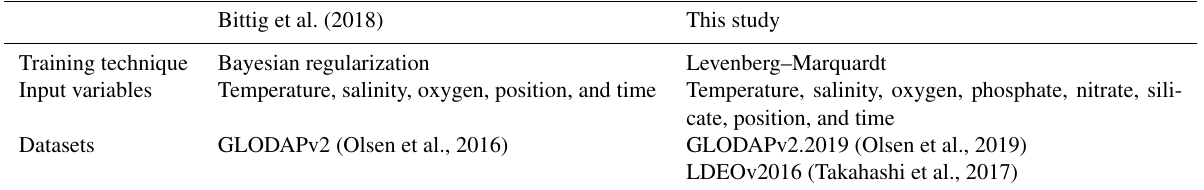
Table 1. Differences between the methods used in the present study and in CANYON-B (Bittig et al., 2018). Bittig et al.